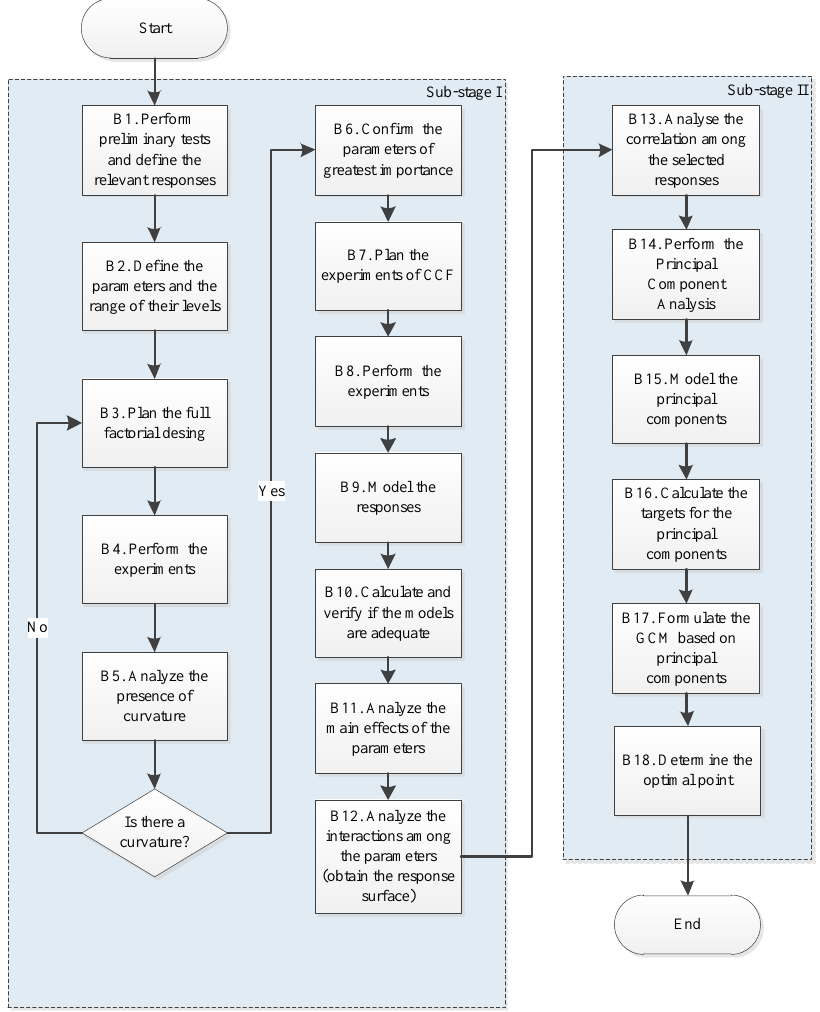
Figure 7. Flowchart of the methodology used in this paper (Stage II).